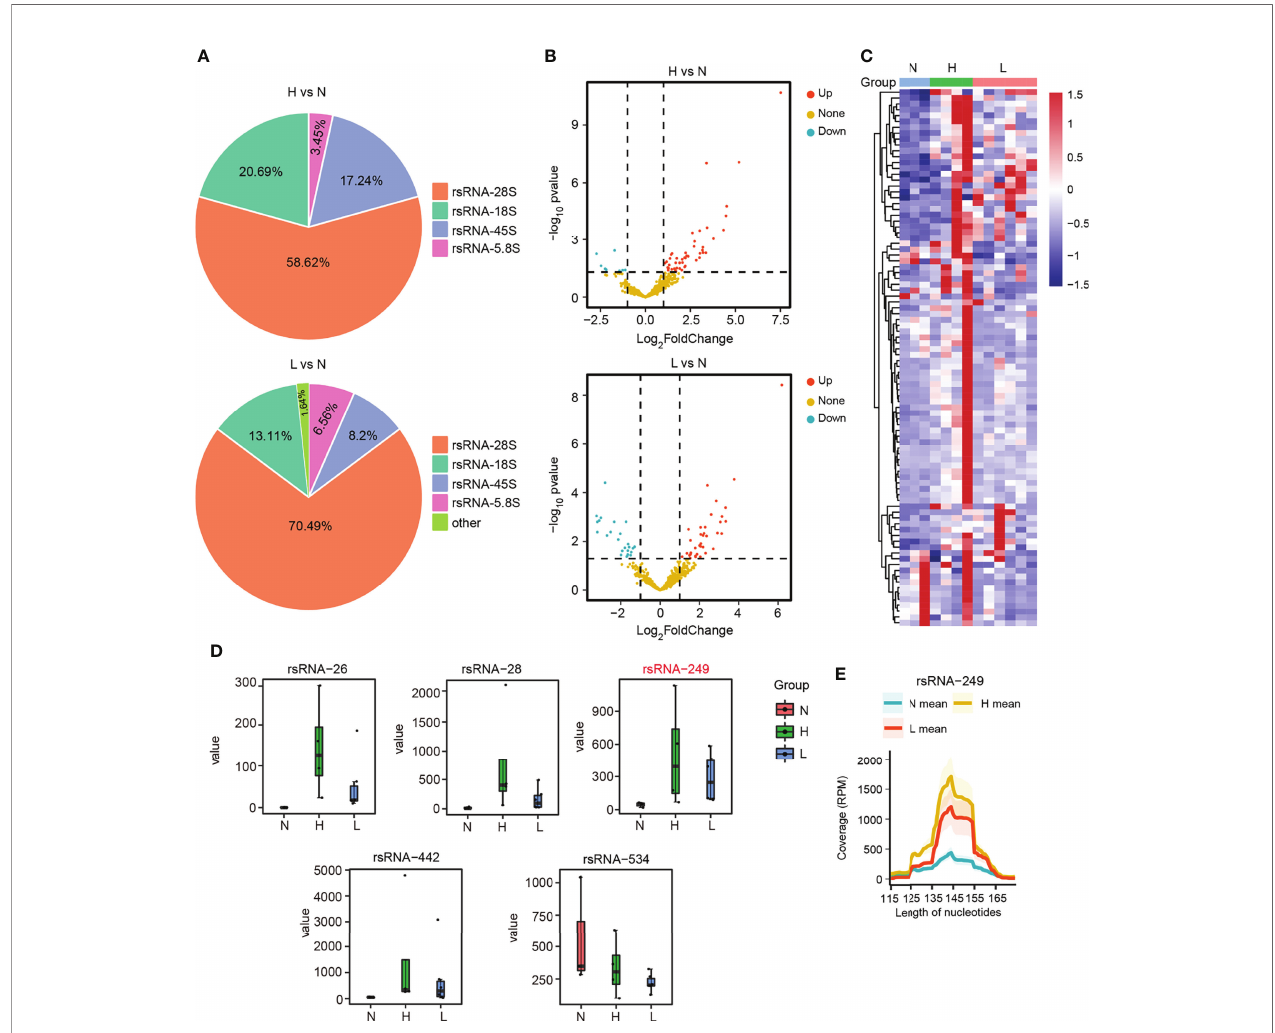
FIGURE 4 | The dysregulated rsRNAs in HBV-ACLF. (A) Percentage of each type of rsRNAs between the comparison groups H vs. N and L vs. N. (B) The volcano plot showed the differentially or non-differentially expressed rsRNAs in the above two comparison groups. (C) The heatmap revealed the differentially expressed rsRNAs in the N, H, and L subjects. (D) The expression pro fi le of rsRNA-26, rsRNA-28, rsRNA-249, rsRNA-442, and rsRNA-534 among the N, H, and L subjects. (E) The coverage pro fi le of the rsRNA-249 sequences of plasma exosomal along